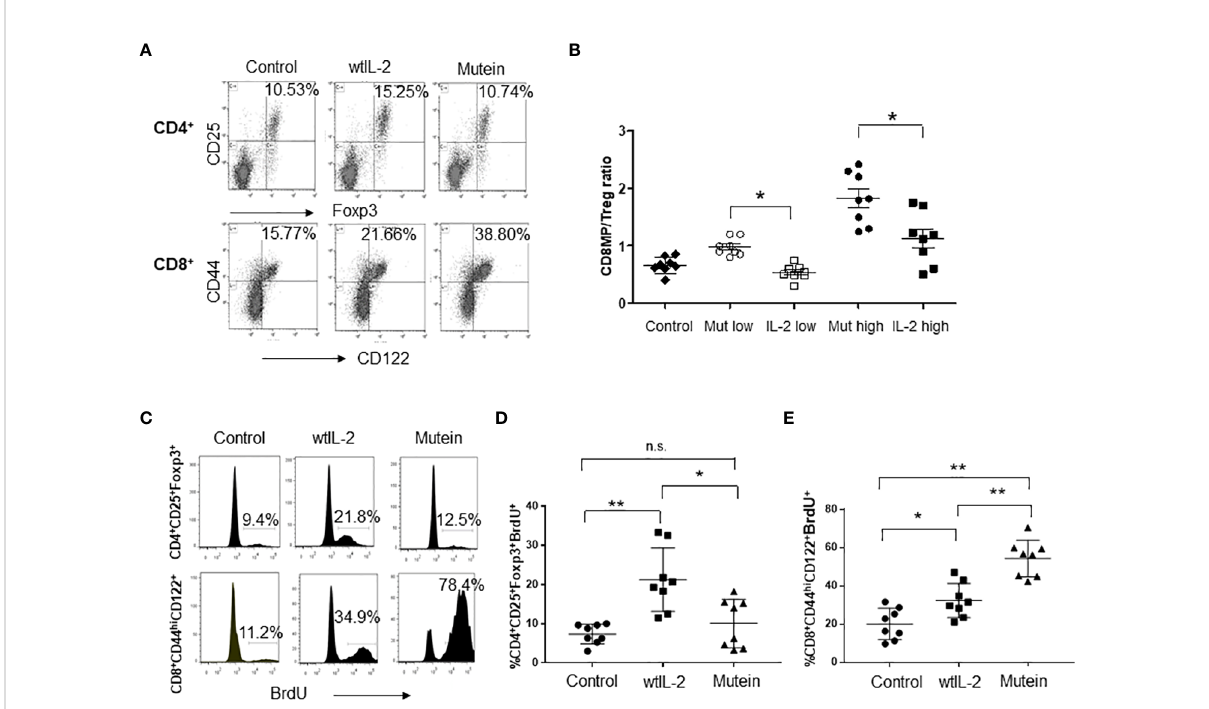
FIGURE 1 No-alpha mutein induces accumulation and proliferation of CD8 + MP cells but not Tregs. Mice were treated i.p. with 20,000 IU of wtIL-2 or 200 IU of mutein during a week, and the percentages and numbers of CD8 + MP and Tregs on the spleens of treated mice were determined. (A) Representative dot plots. (B) CD8 + MP/Treg cell ratio measured on mice treated with two different doses of wtIL-2 and no-alpha mutein: low doses, 20,000 IU of wtIL-2 or 200 IU of mutein; high doses 40,000 IU of wtIL-2 or 400 IU of mutein. The experiment was performed three times; representative data are presented, n = 8 per treatment, p ˂ 0.05, Bonferroni test. For BrdU incorporation, mice were treated with 20,000 IU of wtIL-2 or 200 IU of mutein and fed with BrdU in the water for the last 3 days